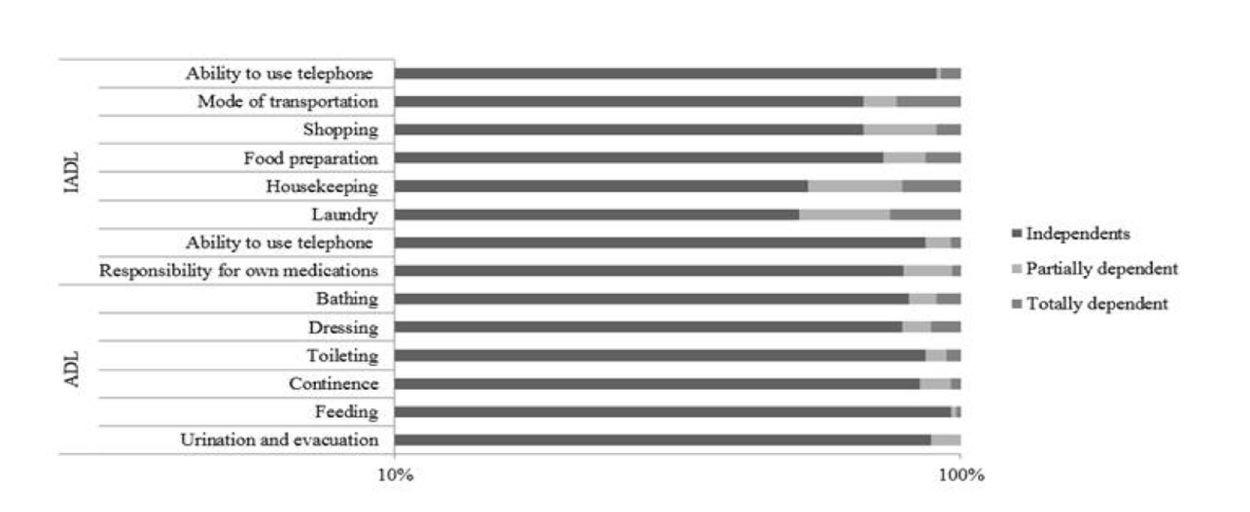
Figure 1 . Degree of dependence ( % ) for the basic and instrumental forms of life in patients with hematologic neoplasms in cancer treatment. Florianopolis,